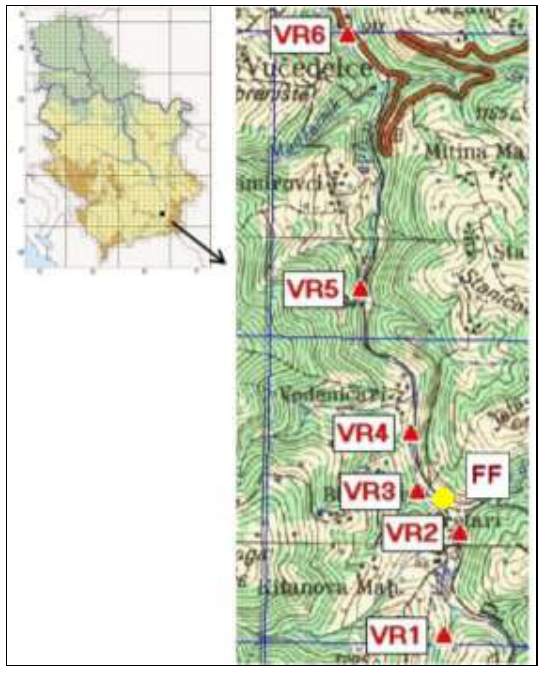
Figure 1. Position of the Vrla River in Serbia (left), sampling sites (VR1-VR6) and fish farm (FF)